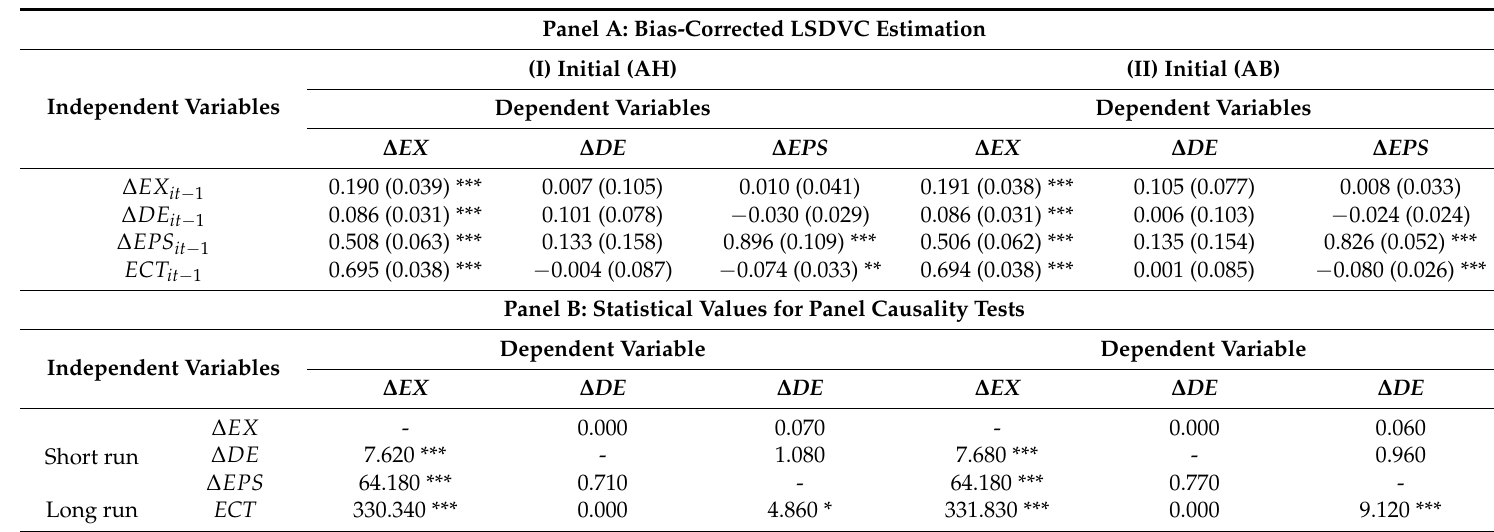
Table 5. Panel Vector Error Correction Results of Dynamic Efficiency of Public Policy-export Nexus (Panel with Time